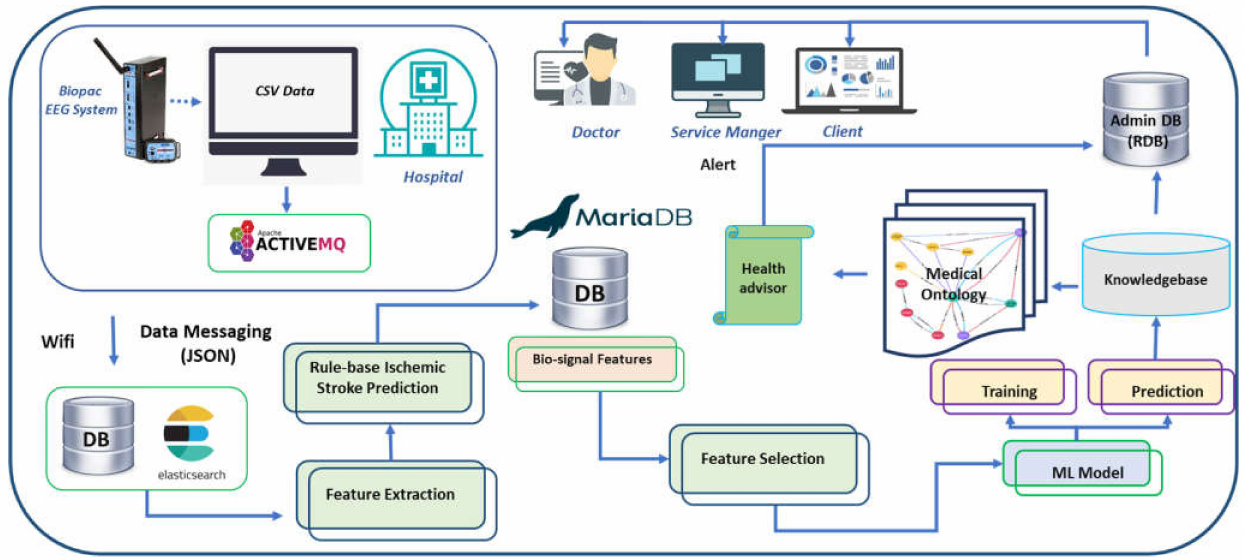
Figure 1. The architecture of the data acquisition framework of the stroke patient monitoring system. Wireless EEG device sends the brainwave of the patients to a nearby computer through Bluetooth communication. EEG data is initially stored in CSV format and then converted to JSON format. An API transfers JSON format EEG HL7 V2 messages to the webserver using ActiveMQ. Feature extraction algorithms extract the neurological features, and rule-based disease prediction labels the data with the possible diseases. The machine-learning model learns and predicts the neural impairment status. Hospitals and clients can monitor the signals and access the health advice through their dedicated